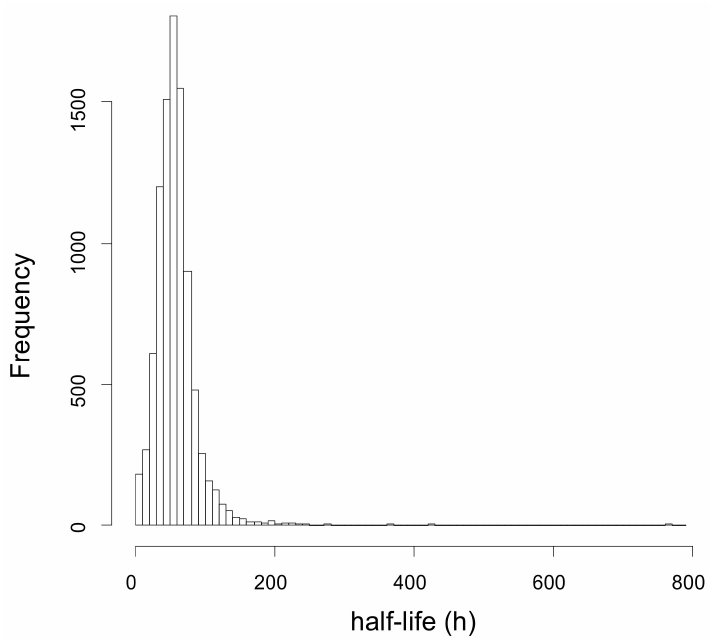
Figure 4. Distribution of the mean values of half-life T 1/2 . The vast majority of proteins show a half-life between 3 and 200 h with an average of 59.9